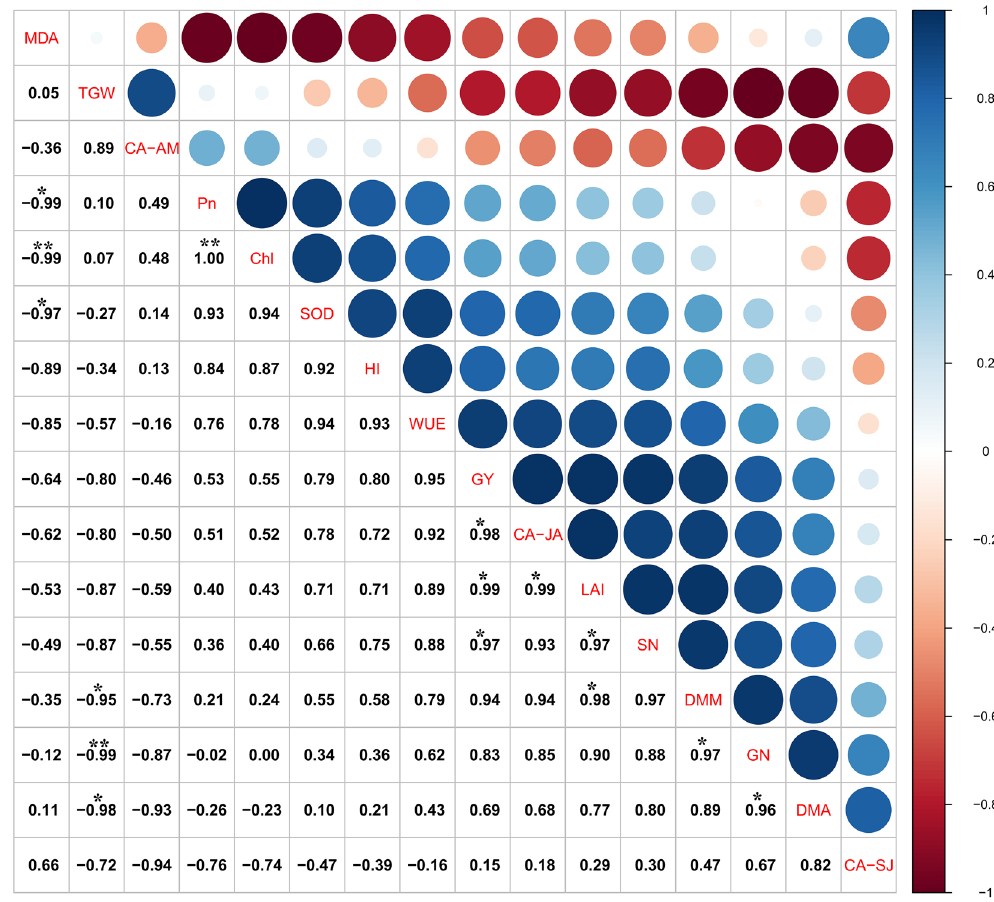
Figure 11. Spearman correlation coefficient matrix and 95% confidence interval of each morphological index is indicated as follows: * P < 0.05; ** P < 0.01. GY, grain yield; SN, spike number; GN, grain number; TGW, 1,000- grain weight; WUE, water use efficiency; CA-SJ, water consumption from snowing to jointing; CA-JA, water consumption from jointing to anthesis; CA-JA, water consumption from anthesis to maturity; DMA, dry matter accumulation at anthesis; DMM, dry matter accumulation at maturity; LAI, leaf area index; HI, harvest index; Pn, photosynthetic rate; Chl, Chlorophyll; MDA, malondialdehyde; SOD, superoxide